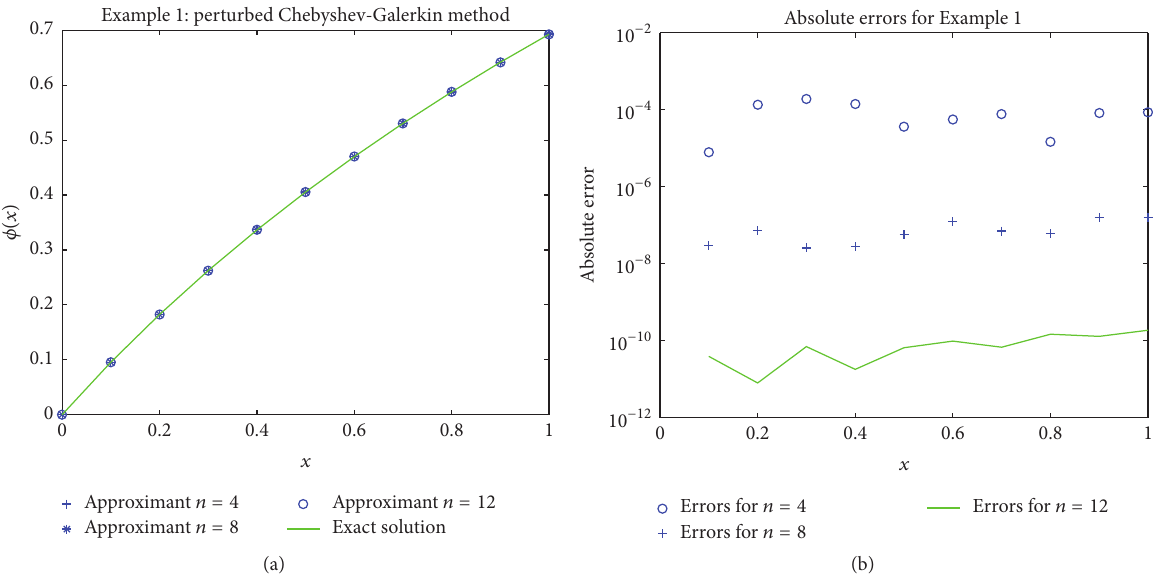
Figure 1: The approximate solution for Example 1 and its absolute errors for different 𝑛 .